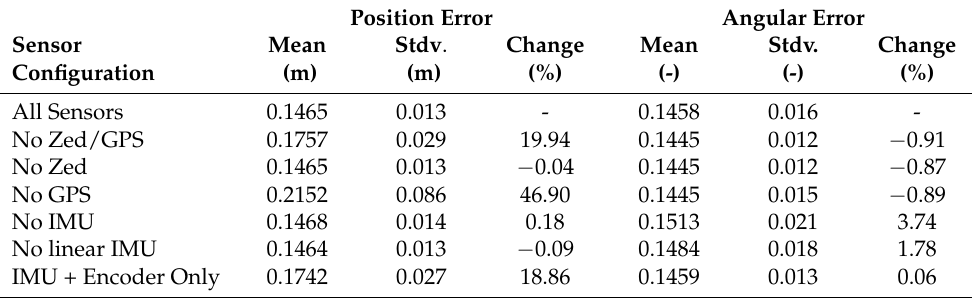
Table 2. Upstream evaluation of localization algorithms with different sensor configurations. Position Error